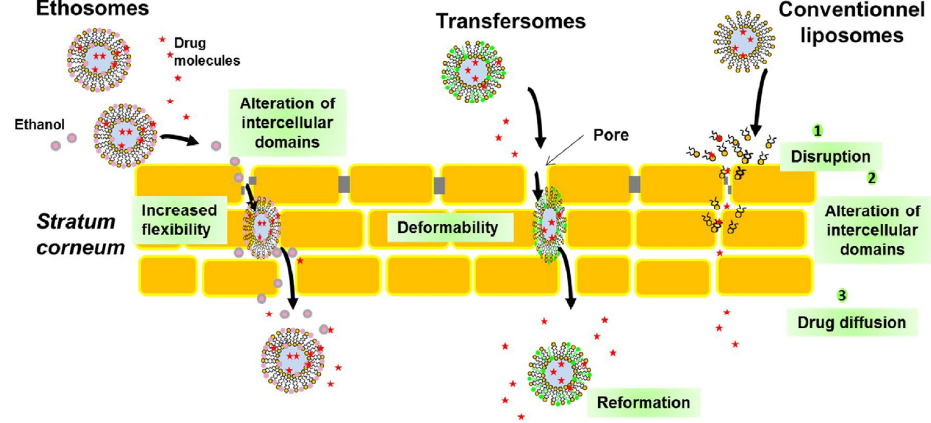
Figure 9. The main permeation mechanisms of different lipid-based nanovehicles [168]. Copyright 2018